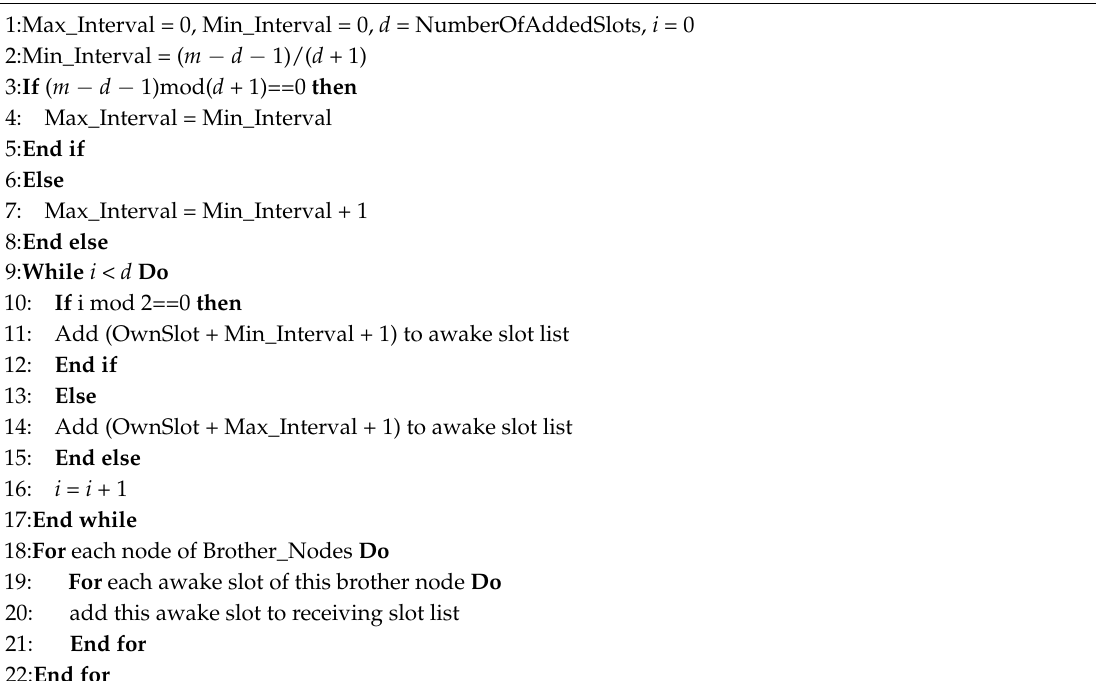
Algorithm 10 Initialize son nodes under AAPS scheme